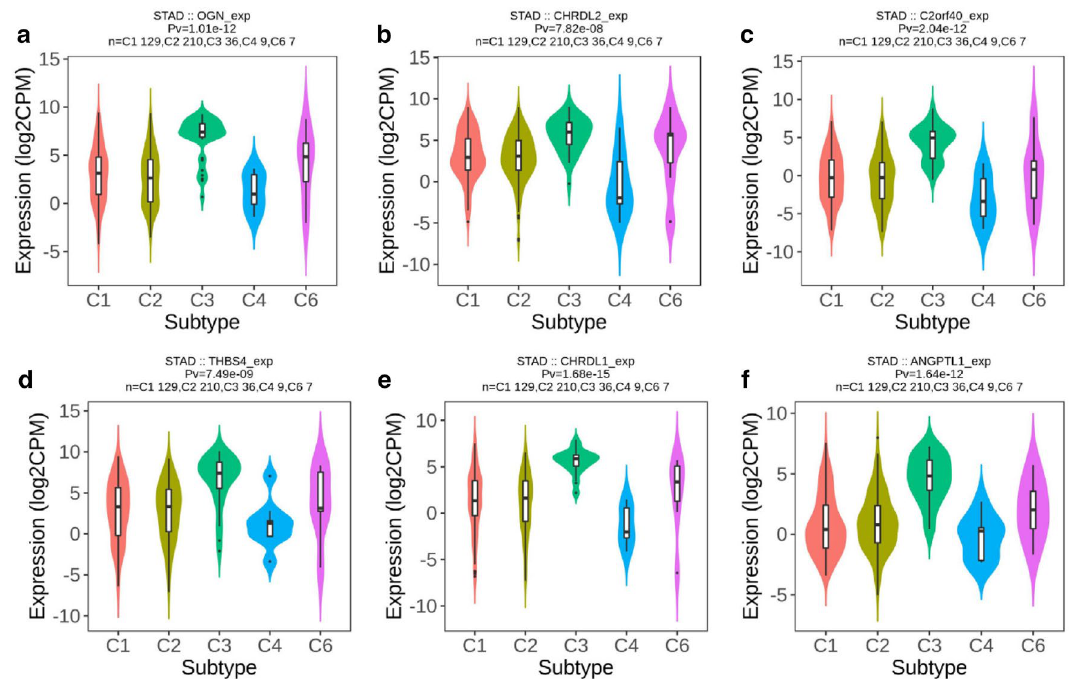
Fig. 7 Associations between expression of six hub genes and immune subtypes in GC. OGN ( a ), CHRDL2 ( b ), C2orf40 ( c ), THBS4 ( d ), CHRDL1 ( e ) and ANGPTL1 ( f ) investigated in TISIDB. C1: wound healing; C2: IFN-γ dominant; C3: inflammatory; C4: lymphocyte depleted; C6: TGF-β